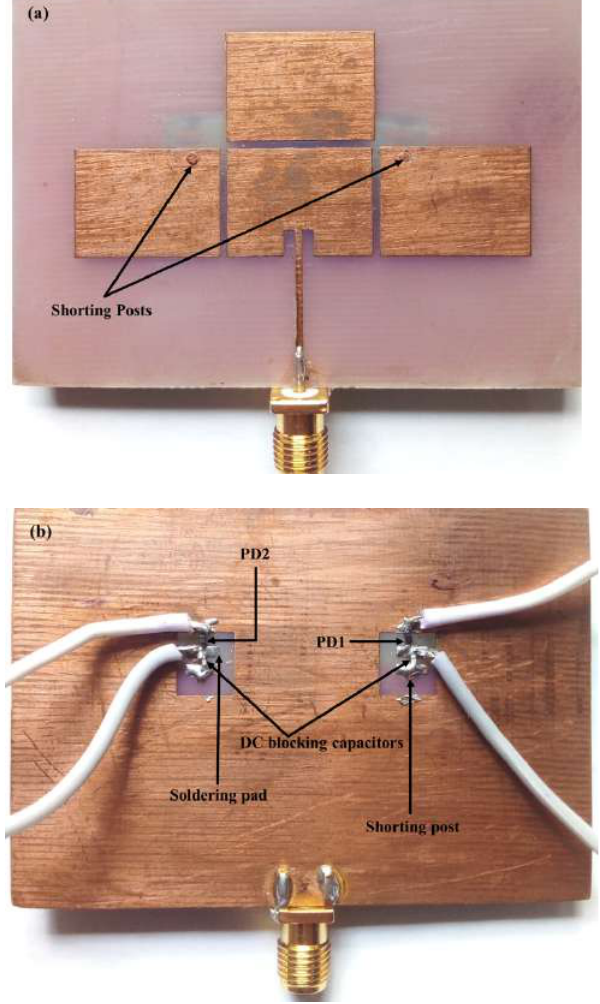
FIGURE 6. Fabricated antenna (a) Top, (b) Back